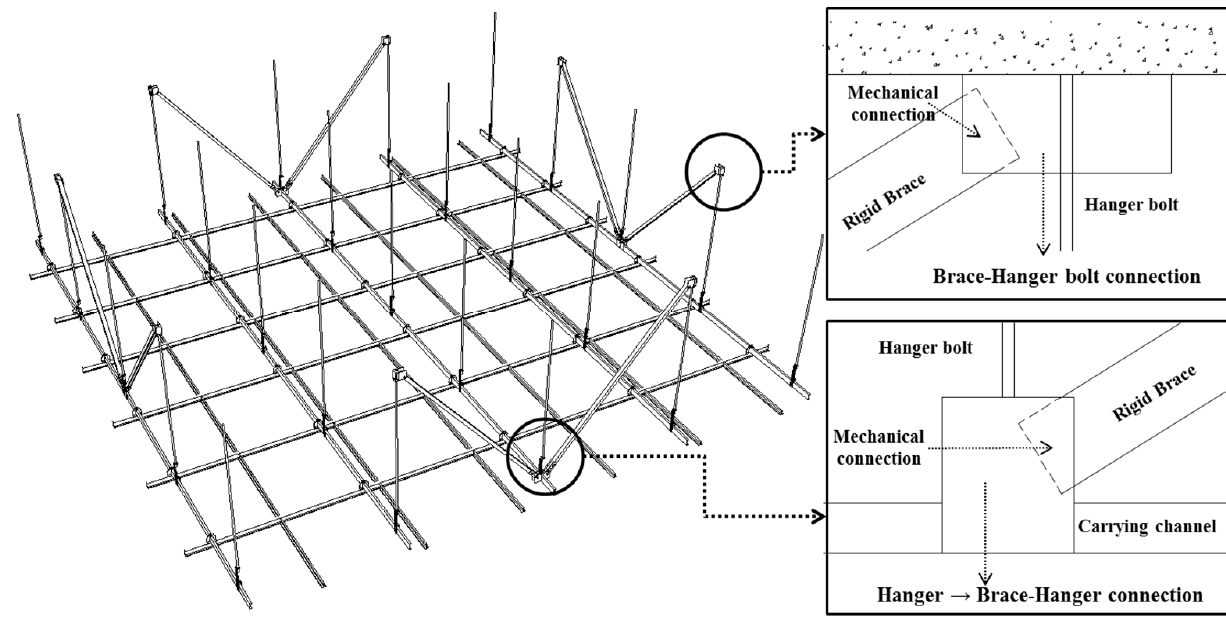
Figure 4. Brace application concept developed for indirect suspended ceiling.